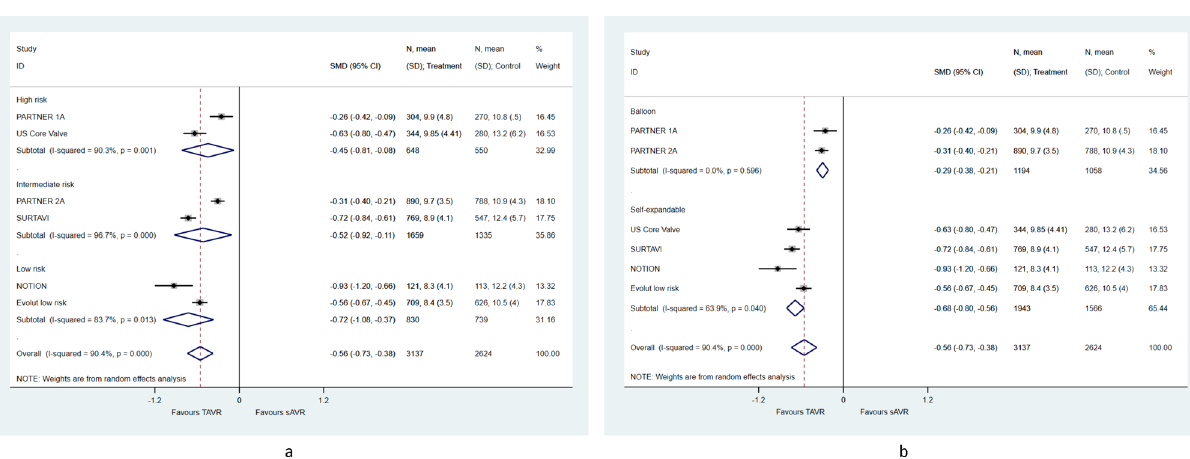
Figure 3. Pooled mean difference of post-procedural gradient at 2 years, according to ( a ) surgical risk on inclusion and ( b ) transcatheter heart valve system .